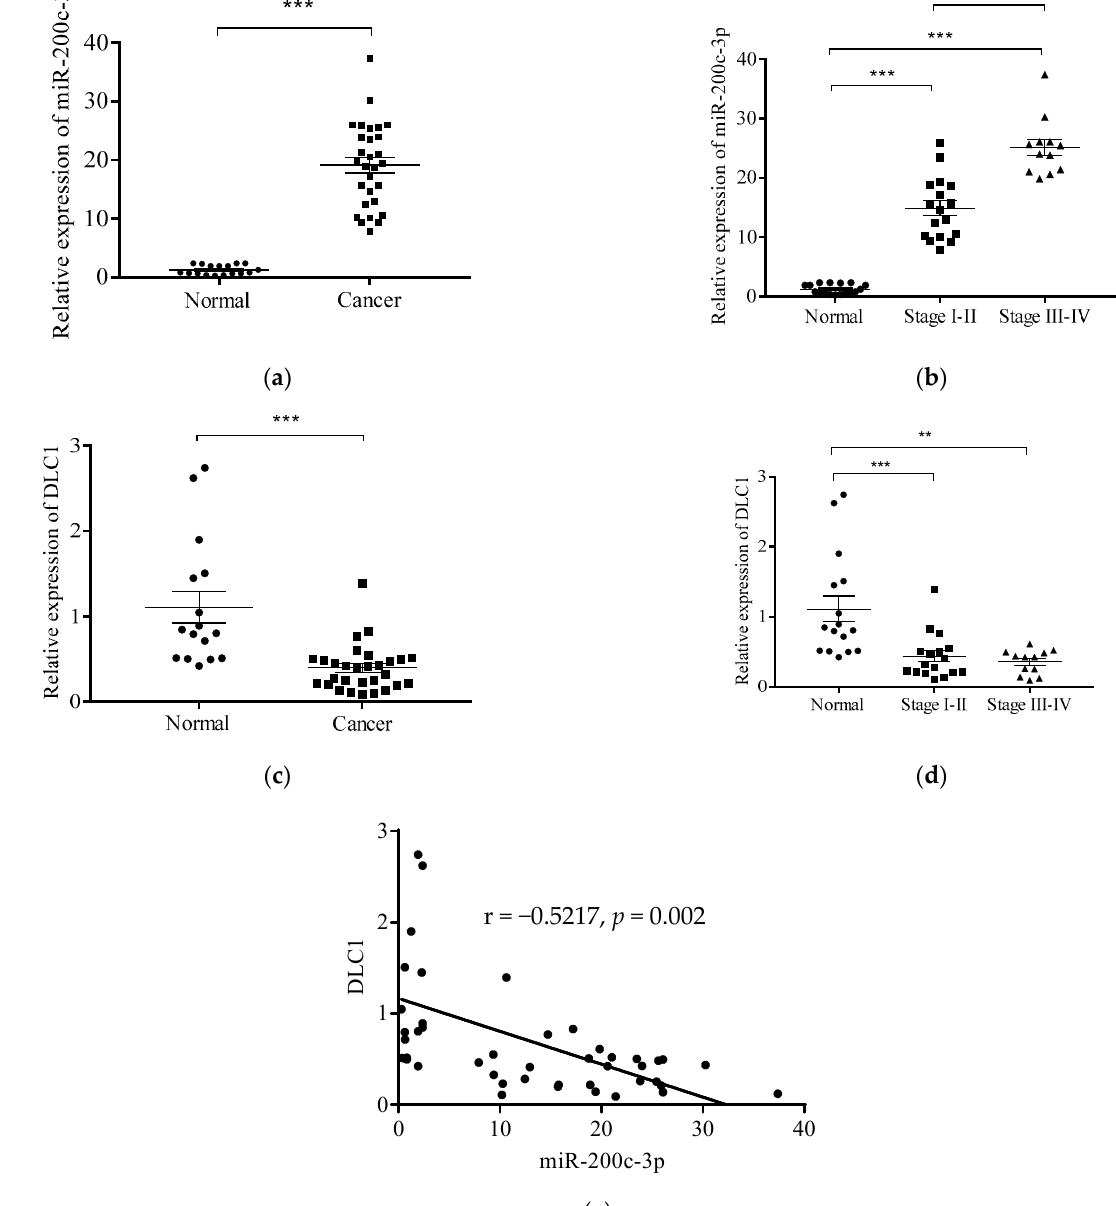
Figure 1. The expression levels of miR-200c-3p and DLC1 are inversely correlated in high grade serous carcinoma. The miR-200c-3p expression by qRT-PCR showing upregulation in cancer tissues ( a ), and different stages of HGSC ( b ). Conversely, the expression level of DLC1 , showing downregulation in cancer tissues ( c ), and different stages ( d ). A negative correlation was shown between miR-200c-3p and DLC1 in both early and late stage of high grade serous carcinoma samples ( e ). Significant values are indicated as follows: ** p < 0.01 and *** p <